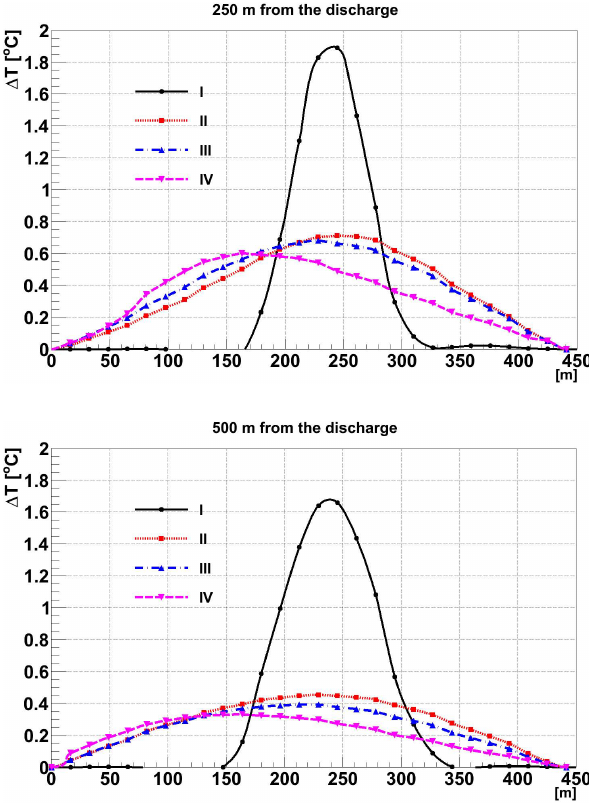
Fig. 4. Distribution of temperature ( 1T ) in case of the point-like continuous discharge in the middle of the channel along the cross- sections located about 250 and 500m from the discharge point: I – with the proper method of the dispersion tensor computation; II – with simplified method in which the off-diagonal elements of dispersion tensor D xy and D yx are omitted; III – with simplified method in which dispersion coefficients D L and D T are treated as a vector; IV – with simplified method in which the diagonal elements of dispersion tensor D xx and D yy are simply replaced by D L and D T , the off-diagonal elements are treated as